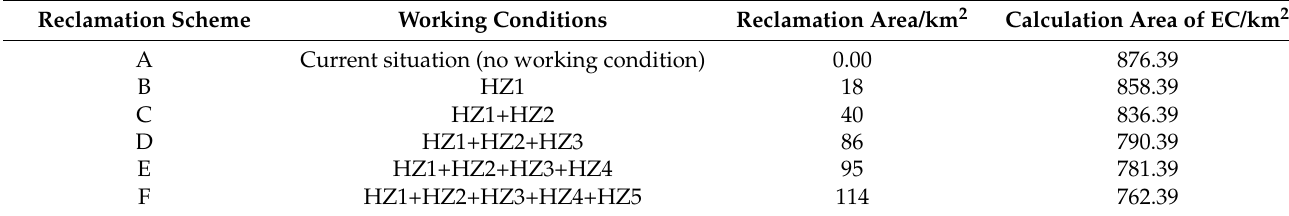
Table 4. Changes in the sea area of Haizhou Bay (scenario 1).